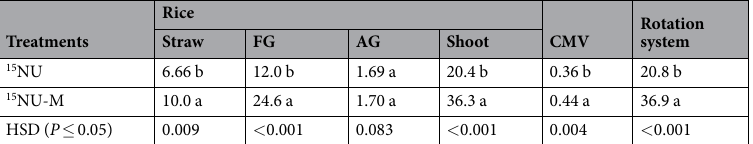
( 15 NU-M) in rice promoted the recovery of 15 N-labeled fertilizer in legume winter cover crop-rice rotation sys- tem (Table 3). When compared with 15 NU alone, substitution of CMV for partial FN ( 15 NU-M) in rice signifi- cantly increased the recovery of 15 N in shoot of rice plants by 77.9% (50.2% and 105.0% in rice straw and filled grains respectively), and by 22.2% in shoot of cover crop plants. Consequently, the 15 N recovery in the rice-based